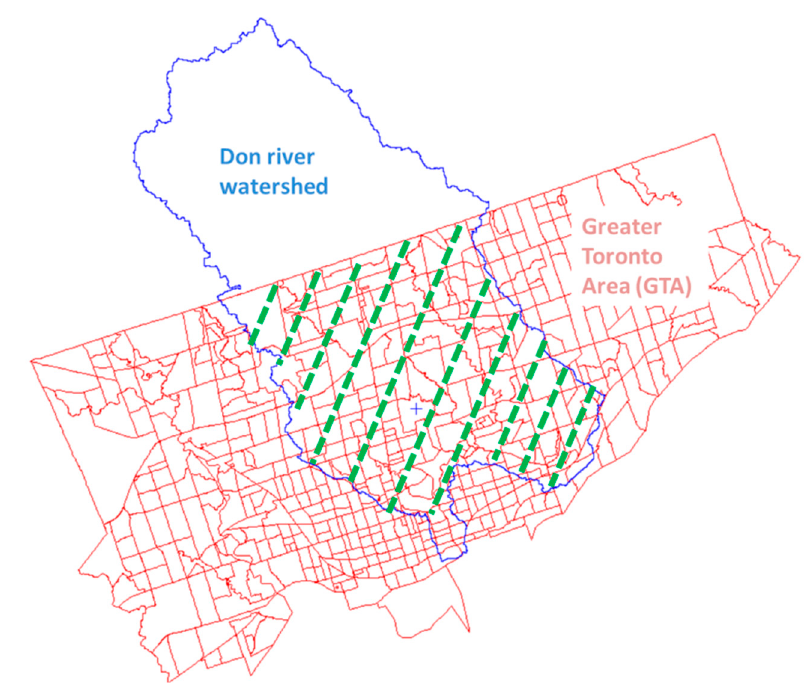
Figure 3. Study area (dashed green lines). The blue region is the Don River watershed, with an extent of 38 km emptying into Lake Ontario, Canada. The red vector layer represents the Greater Toronto Area, which is a heavily populated conurbation.